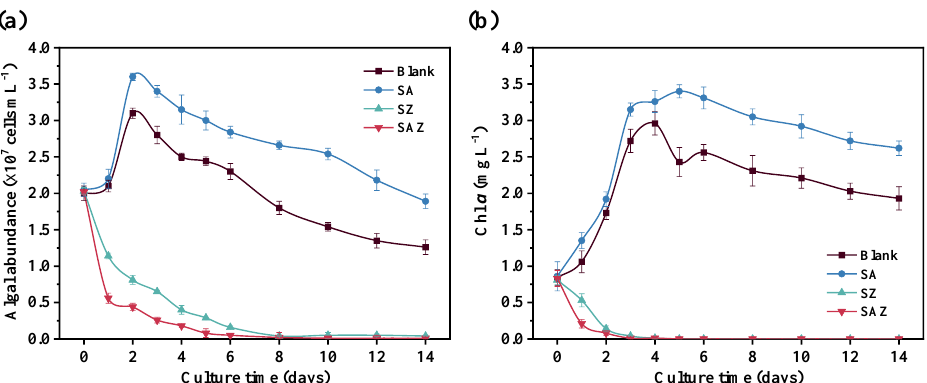
Figure 1. Growth curves ( a ) and Chl a concentration ( b ) of S. dohrnii with different treatment in artificial seawater. Blank, S. dohrnii only; SA, with penicillin for S. dohrnii ; SZ, with Zn 2+ for S. dohrnii ; SAZ, with penicillin and Zn 2+ for S. dohrnii . Each value represents mean ± SD ( n = 3). Note error bars are smaller than the symbol sizes in some cases. Table 1. Specific growth rate and doubling time of S. dohrnii with different treatment in artificial seawater. Treatment